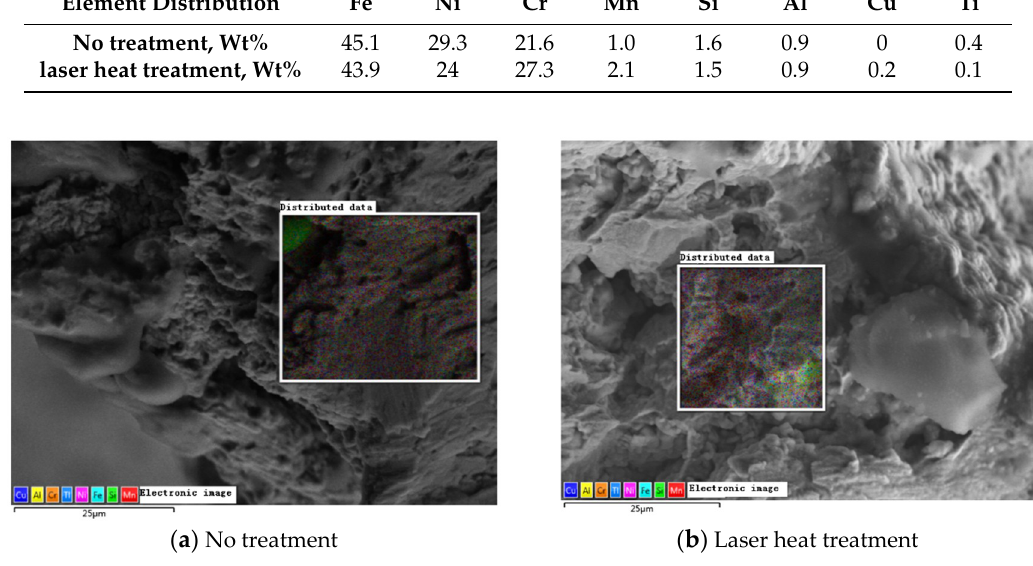
Figure 5. Energy spectrum layered diagram of alloy 800H.